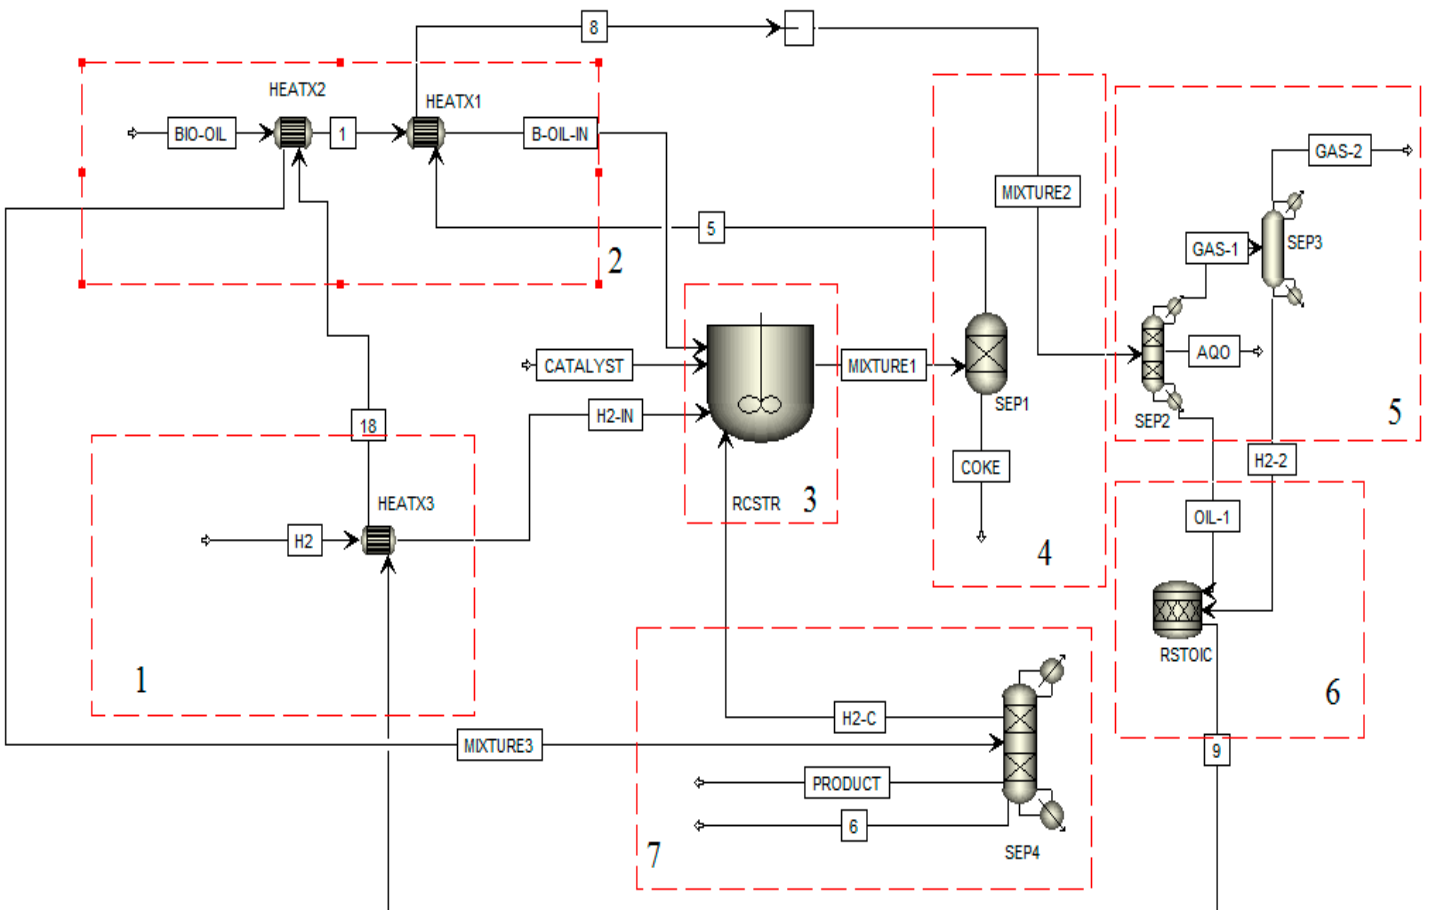
Figure 2. Bio-oil hydrogenation reaction process.